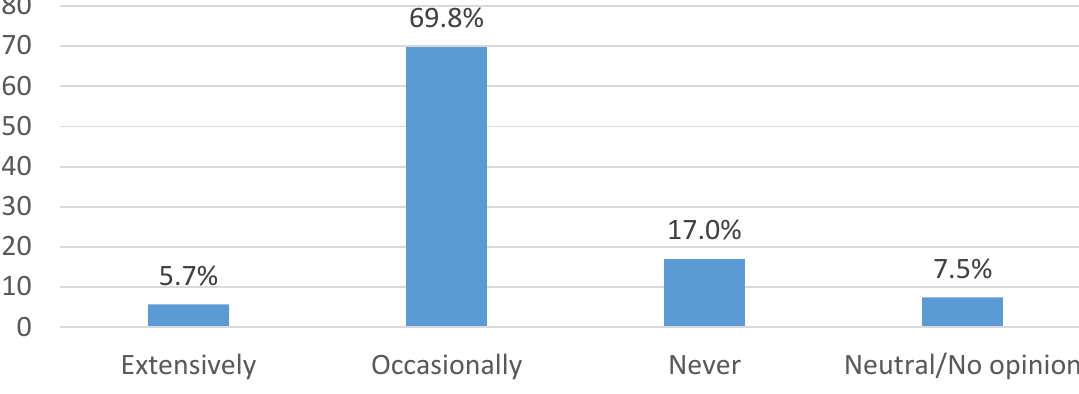
Figure 4. Staging the Olympic games has negative impacts on the